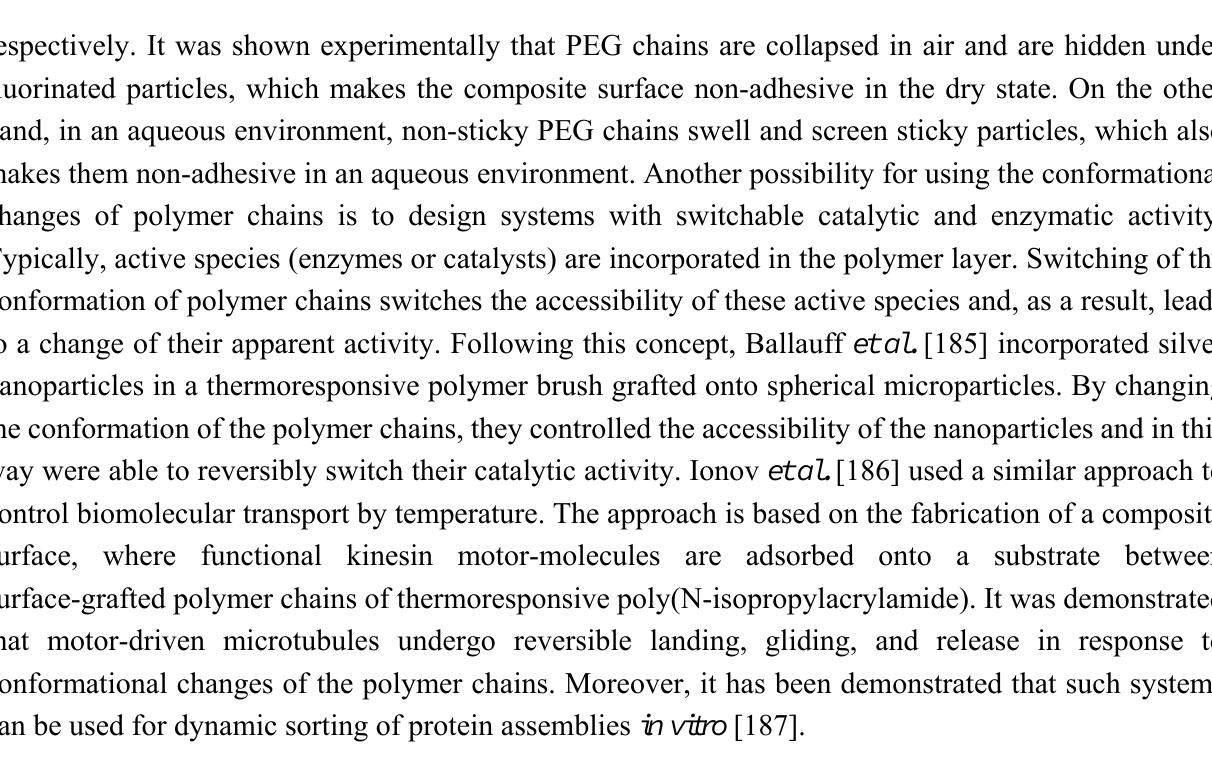
Figure 14. Schematic of the process for capture and release specific DNA by a tethered poly(N-isopropylacrylamide) (PNIPAAm) in the channel surface of a fluid device from a specimen with lysed human blood cells. Reprinted from Reference [181] with